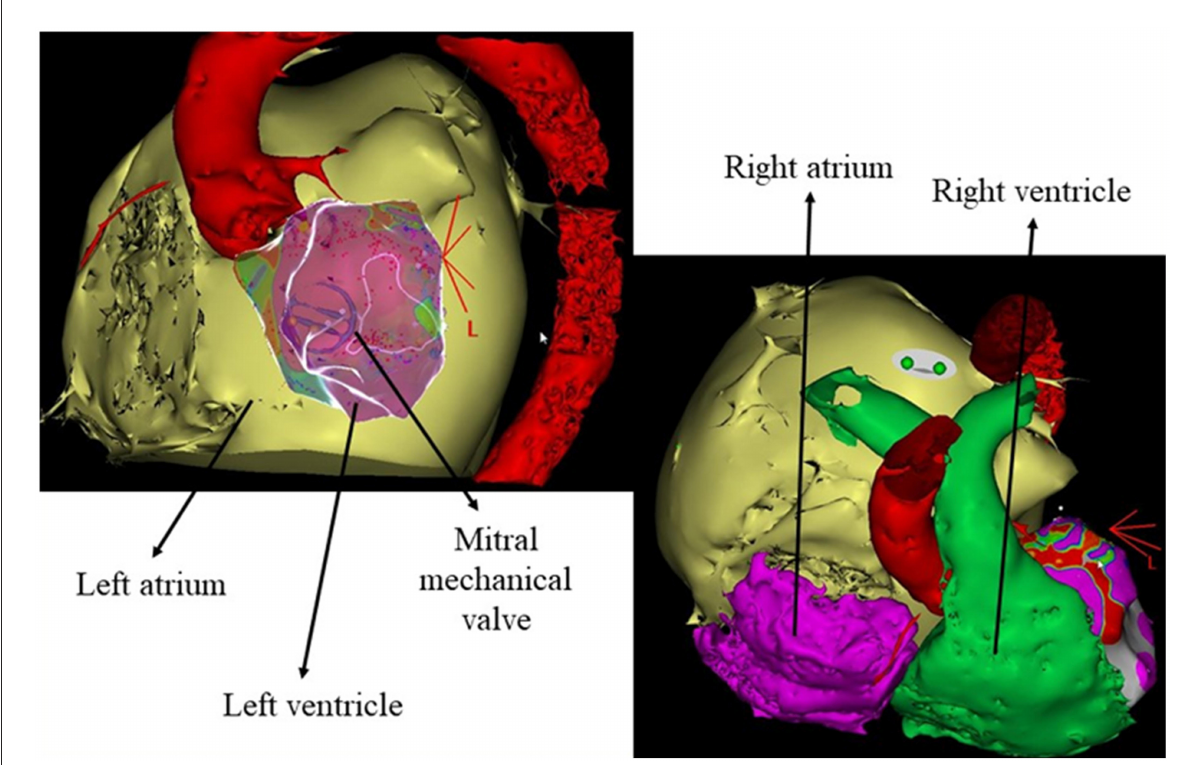
FIGURE1 Anatomical details reconstructed from the preprocedural cardiac CT scan. Aorta in red, left atrium in yellow, right atrium in purple, and right ventricle in